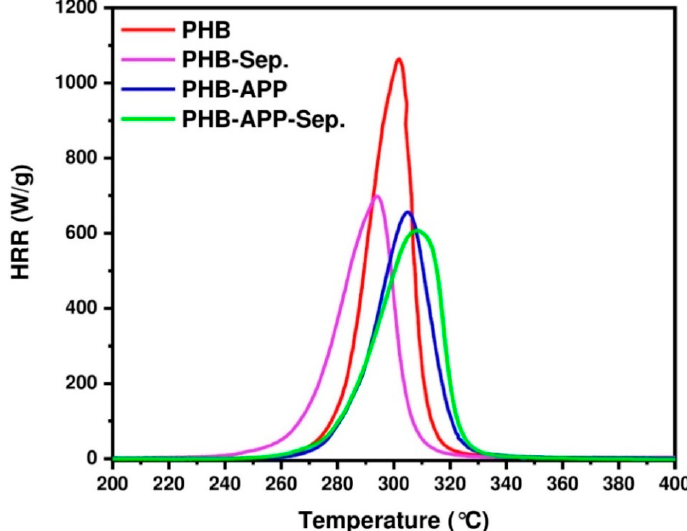
Figure 7. Heat Release Rate (HRR) curves obtained in Pyrolysis Combustion Flow Calorimeter PCFC tests. Table 9. Summary results of Pyrolysis Combustion Flow Calorimeter (PCFC) tests.